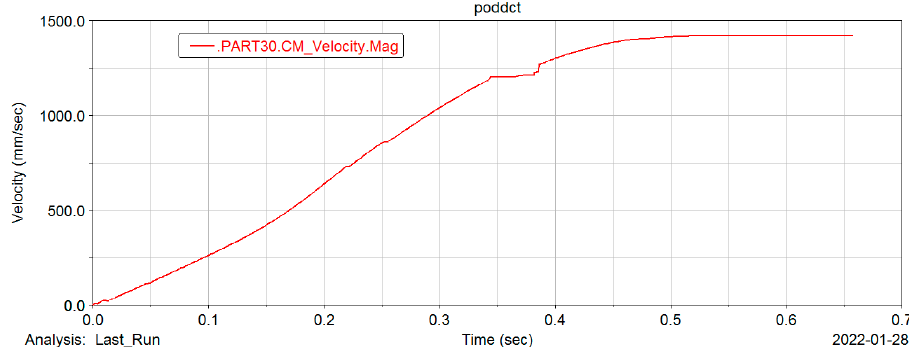
Figure 13. The curve of separation velocity variation.